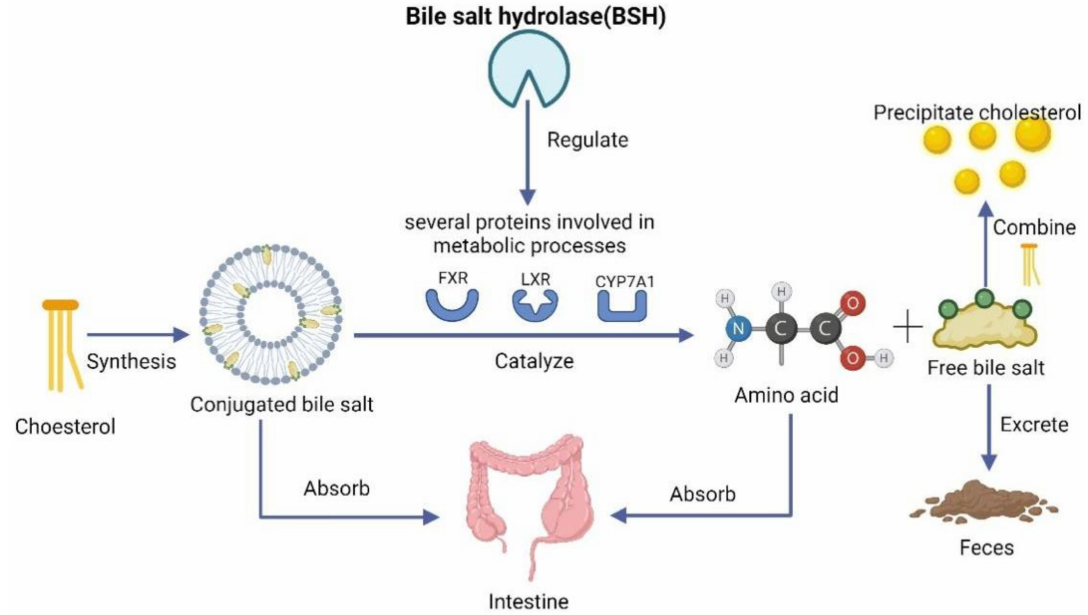
Figure 3. Mechanism of cholesterol lowering by Lactiplantibacillus plantarum via bile acids. Lactiplantibacillus plantarum reduces cholesterol by regulating the metabolism of bile acids that con- sume cholesterol, as well as promoting the combination of bile acids and cholesterol into precipitates. (FXR—farnesoid X receptor, LXR—liver X receptor, CYP7A1—cholesterol 7 α -hydroxylase) (Created with